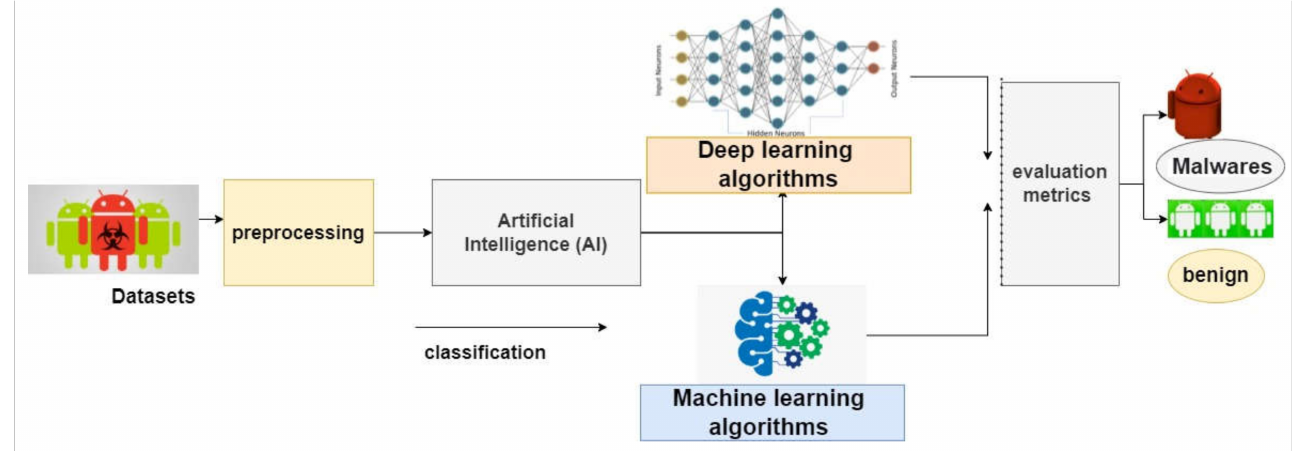
Figure 3. A generic representation of the models applied for the detection of Android